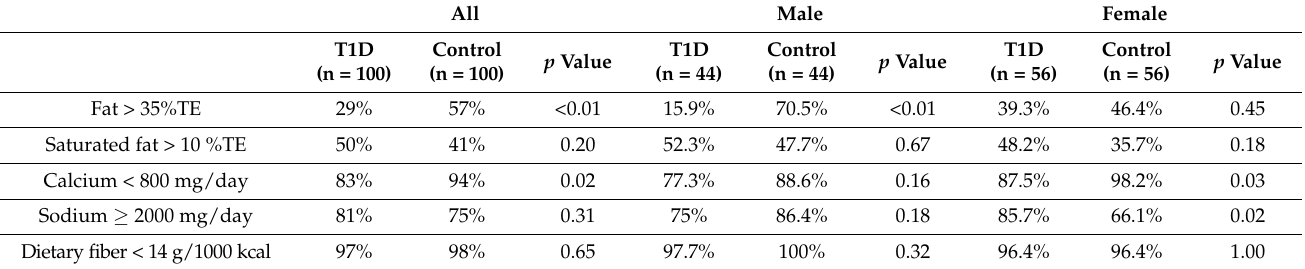
Table 4. The percentage of participants who did not meet nutritional recommendations compared between those with and without type 1 diabetes for the entire study population, for male study participants, and for female study